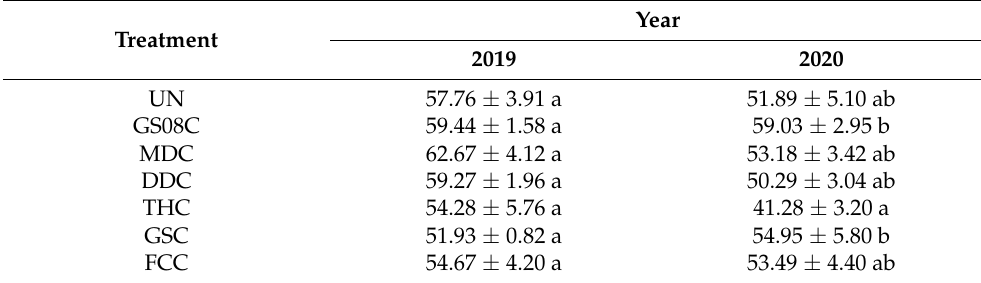
Table 4. Mean ( ± SE) percentage of damaged nodules in broad bean at BBCH 65 (flowering growth stage) when treated at different times with insecticide in 2019 and 2020.